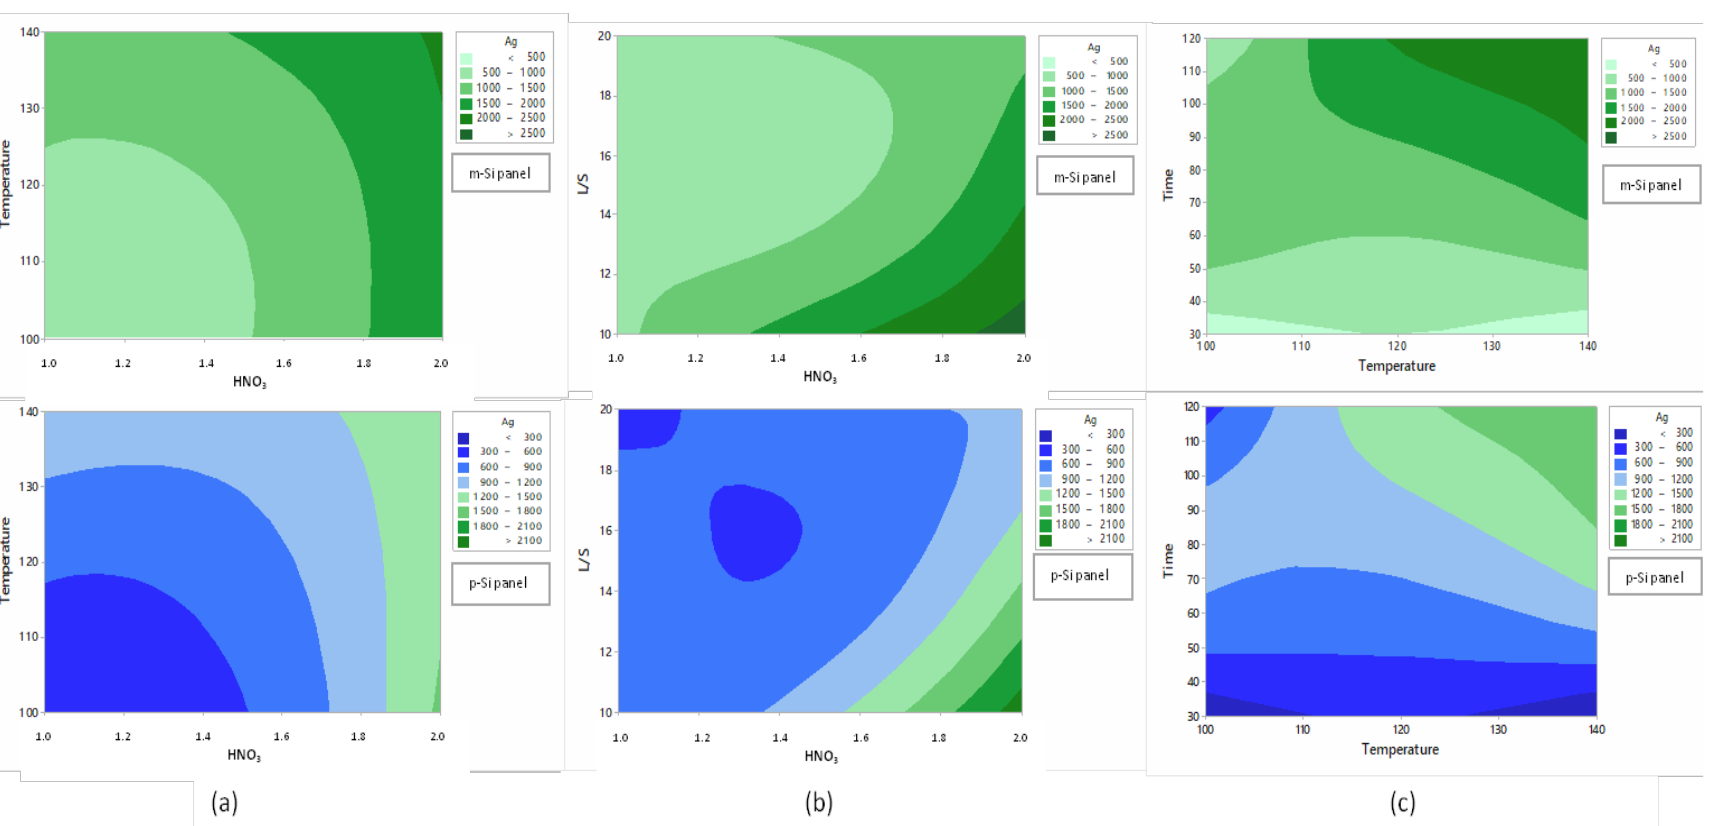
Figure 5. Fitted contour plots for m-Si and p-Si panels: ( a ) Ag concentration vs. temperature and HNO3; ( b ) Ag concentration vs. L/S and HNO 3 ; ( c ) Ag concentration vs. time and temperature.